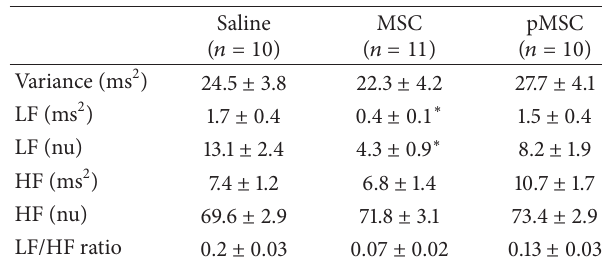
Table 2: Effect of stem cell treatment on heart rate variability in all three experimental